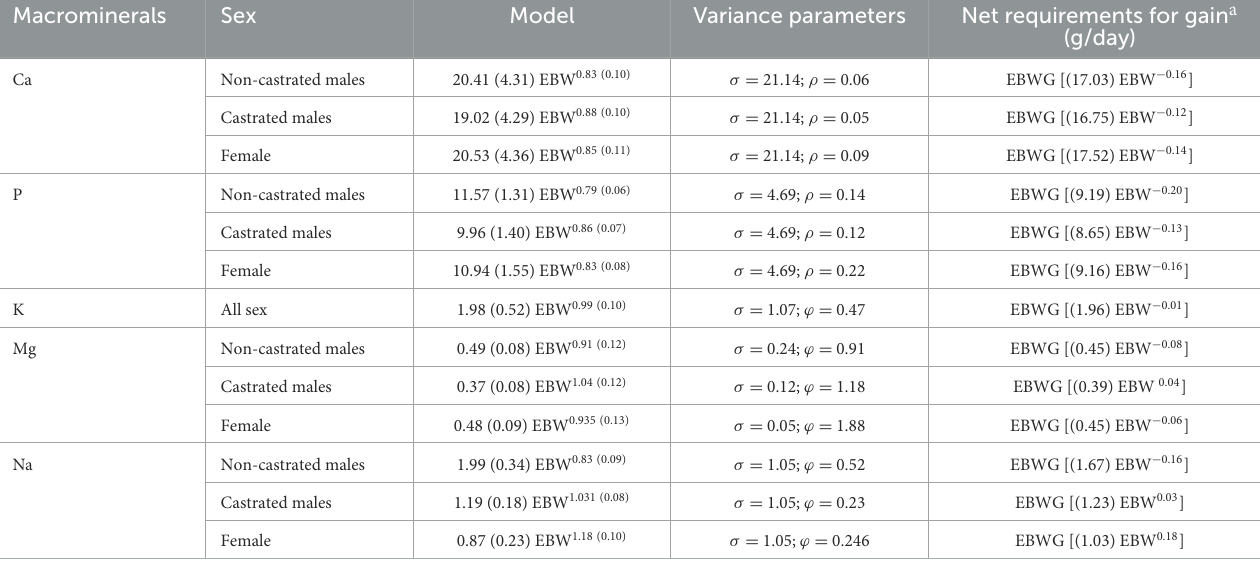
TABLE 4 Models for estimating body composition and net requirements for gain of hair sheep. Macrominerals